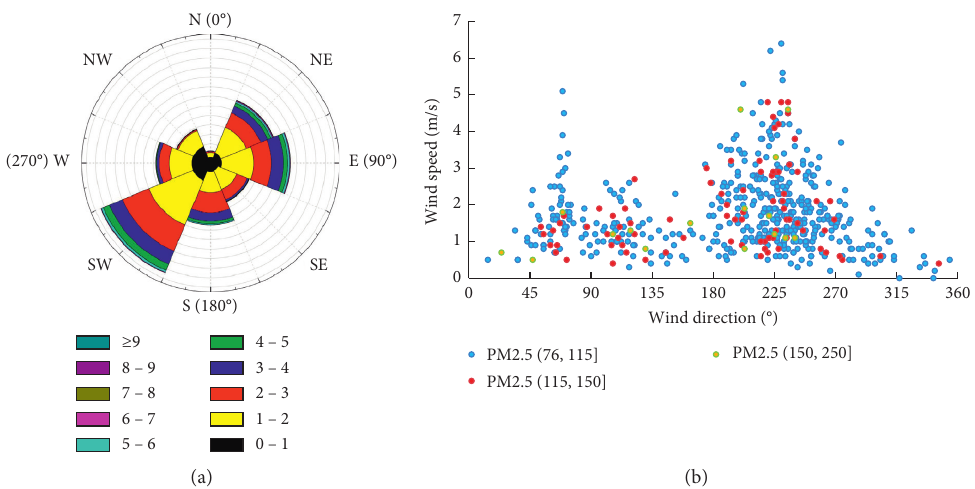
Figure 12: The wind rose diagram at Qinhuangdao. (a) The relationship between PM2.5, (b) mass concentration, and wind speed and wind direction in summer.